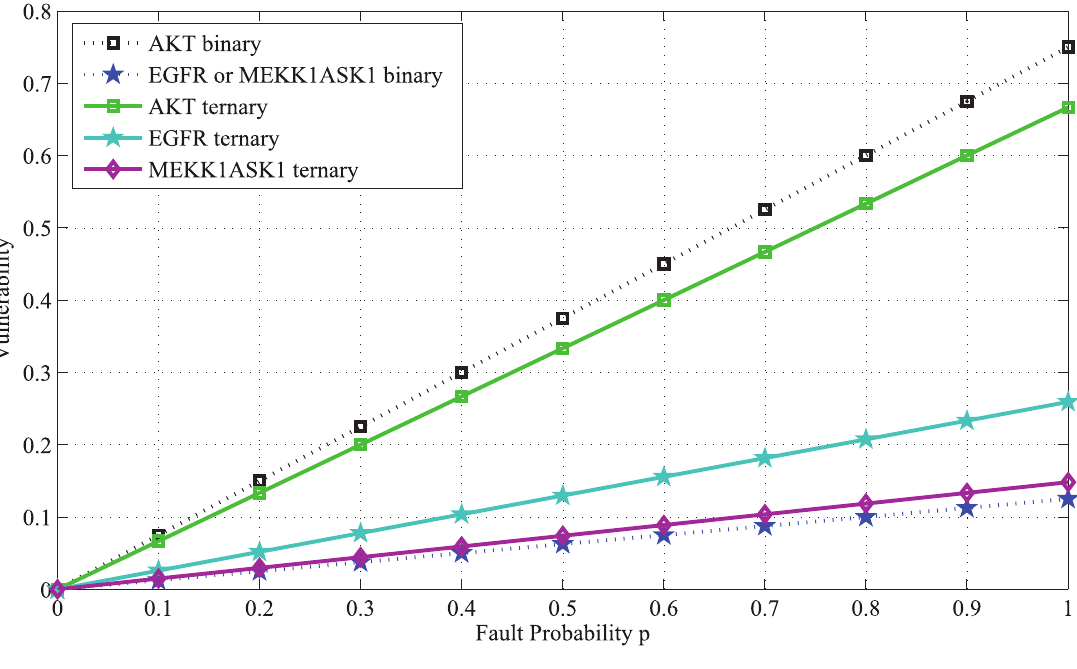
Figure 10. Comparing vulnerabilities in the caspase3 network obtained via binary and ternary network models. In this figure dashed and solid graphs represent vulnerabilities for binary and ternary activity models, respectively. In both models AKT shows high vulnerability. While in the binary model EGFR and MEKK1ASK1 exhibit the same vulnerablity, the ternary model shows somewhat different yet still low vulnerability for EGFR. Since vulnerablities for the rest of the molcules are very low in both models, they are not shown, to keep the figure easy to read.